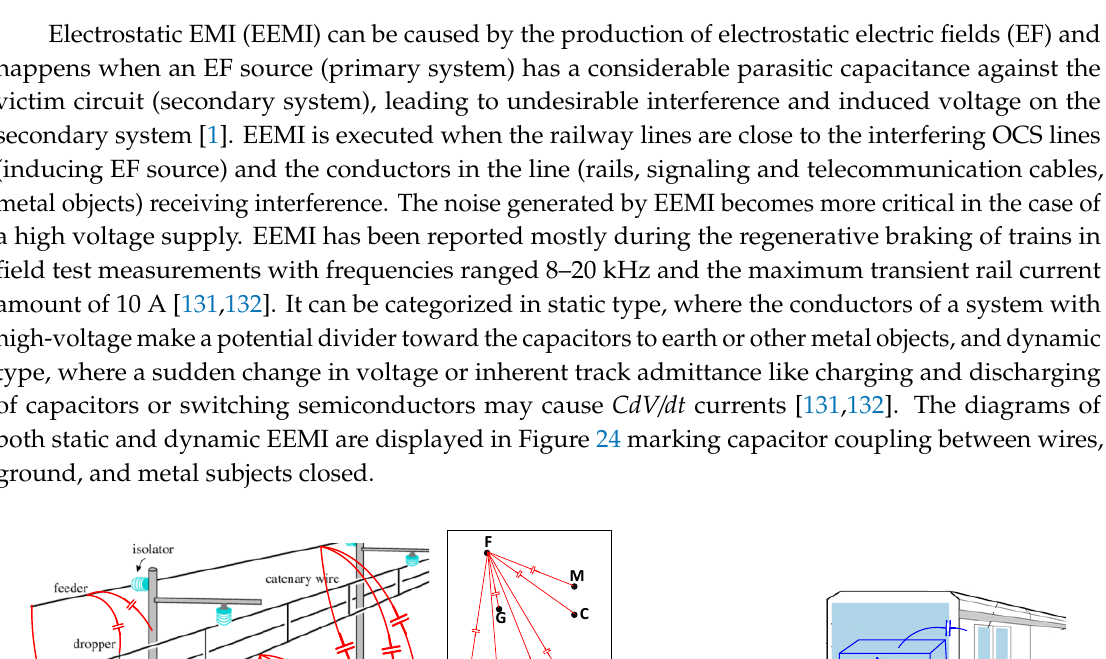
Figure 23. The induced and touch voltage on a conductor parallel to ERPS track. ( a ) Induced voltage based on the distance of the conductor [ 131 ]. ( b ) Induced voltage based on frequency for both 1 × 25 kV and 2 × 25 kV ERPSs [ 132 ].